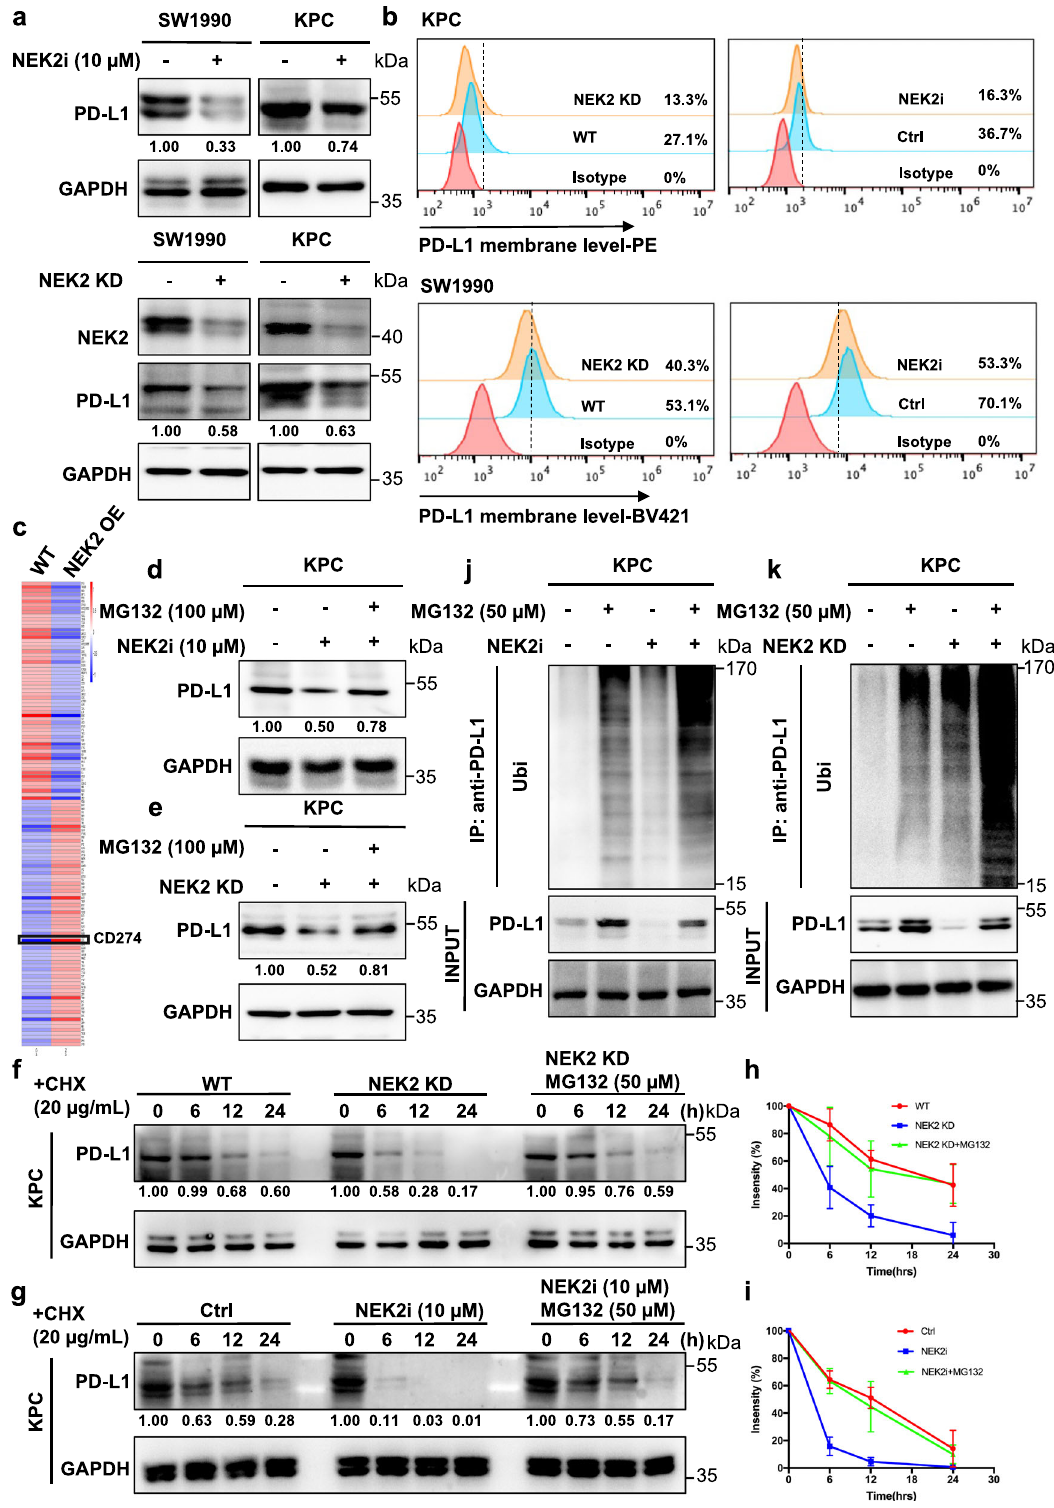
Recombinant (396414, Biolegend, 1:200), PE anti-mouse Perforin (154306, Biole- gend, 1:200), APC anti-mouse TNF- α (506308, Biolegend, 1:200), BV785 anti- human CD45 (304047, Biolegend, 1:200), PE/Cy7 anti-human CD11b (301322, Biolegend, 1:200), FITC anti-human CD68 (333806, Biolegend, 1:200), PerCP/ Cyanine5.5 anti-human HLA-DR (307630, Biolegend, 1:200), APC/Cy7 anti- human CD11c (337218, Biolegend, 1:200), APC anti-human CD15 (301908, Bio- legend, 1:200), PE anti-mouse CD274 (124308, Biolegend, 1:200), Brilliant Violet 421 anti-human CD274 (329714, Biolegend, 1:200), PE rat IgG2b, κ isotype control